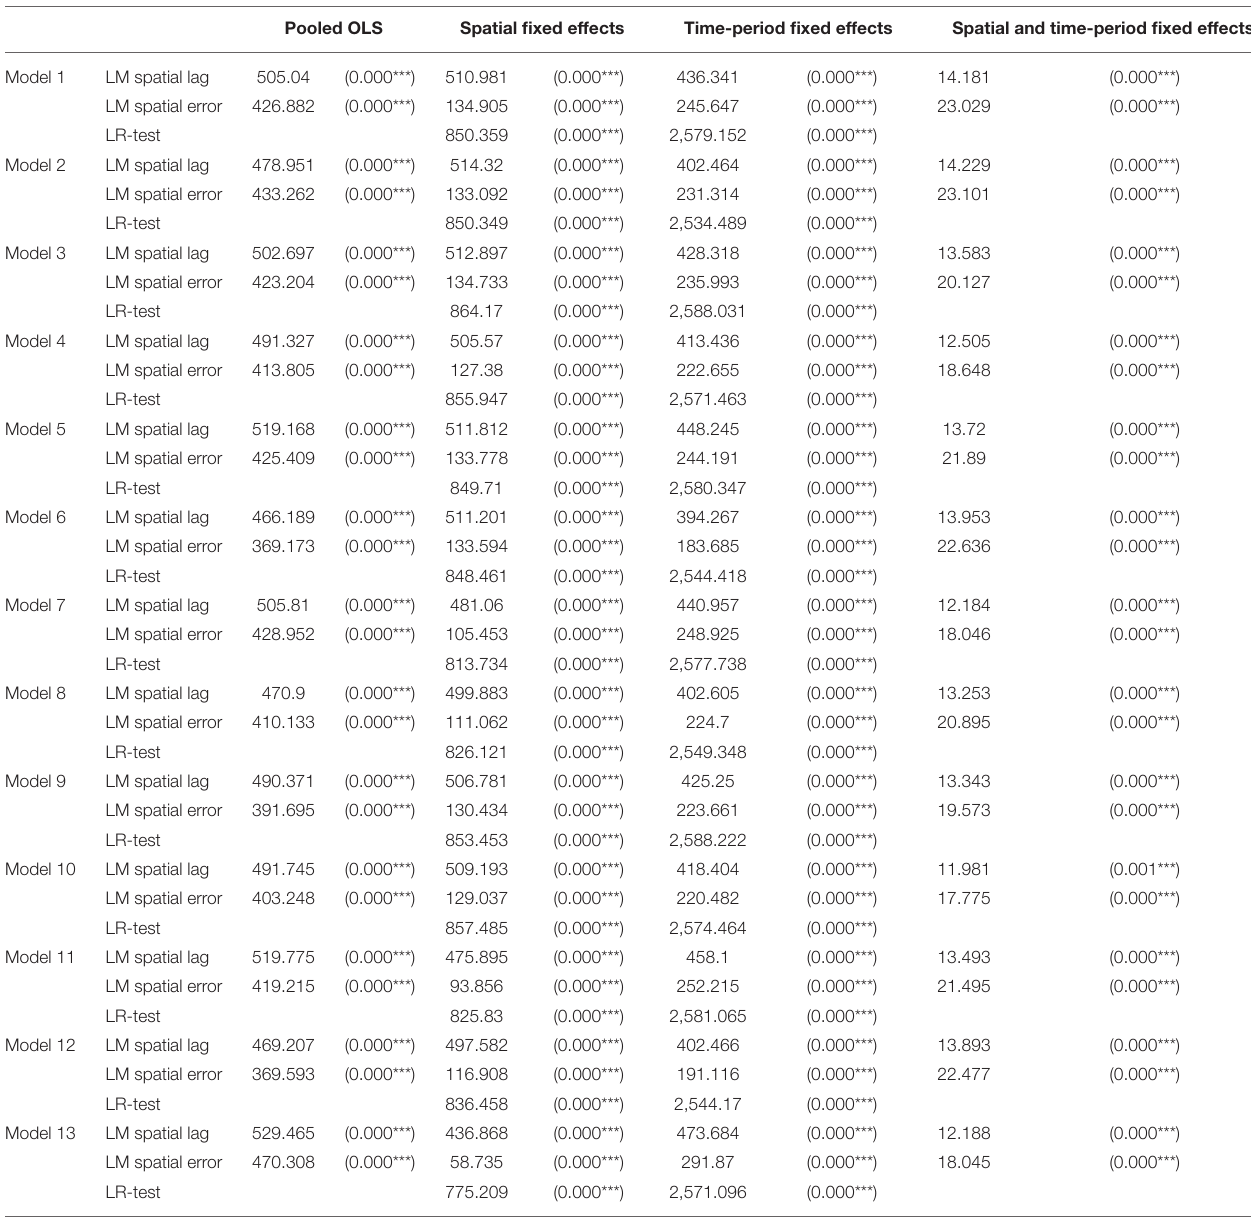
TABLE 3 | Spatial lag or the spatial error in the spatial and time-period fixed-effect